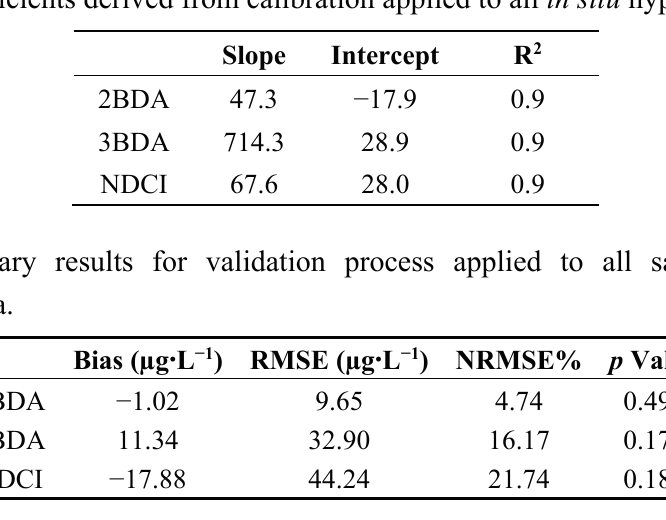
Table 6. Coefficients derived from calibration applied to all in situ hyperspectral data.